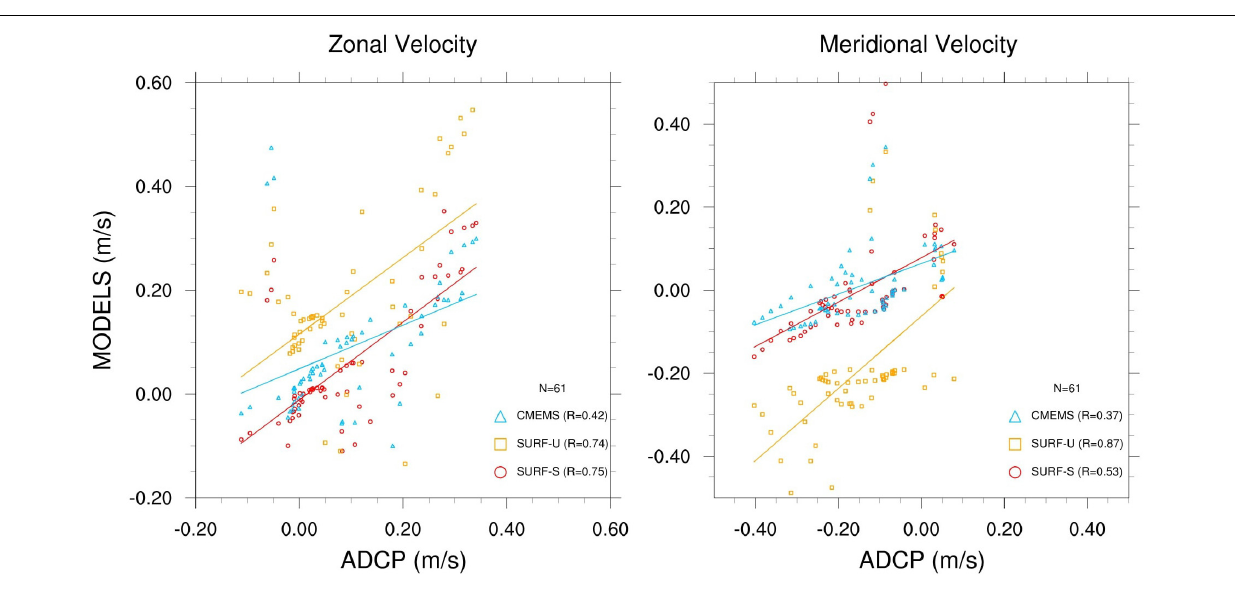
FIGURE 12 | Scatter diagram of zonal ( left panel ) and meridional ( right panel ) components between the ADCP velocity and the structured SURF-S velocity (red circles), the unstructured SURF-U velocity (orange squares), and the CMEMS velocity (blue triangles). The regression for each model is indicated by the straight line. Numbers of data (N) used and correlation coefficients (R) are also shown in each